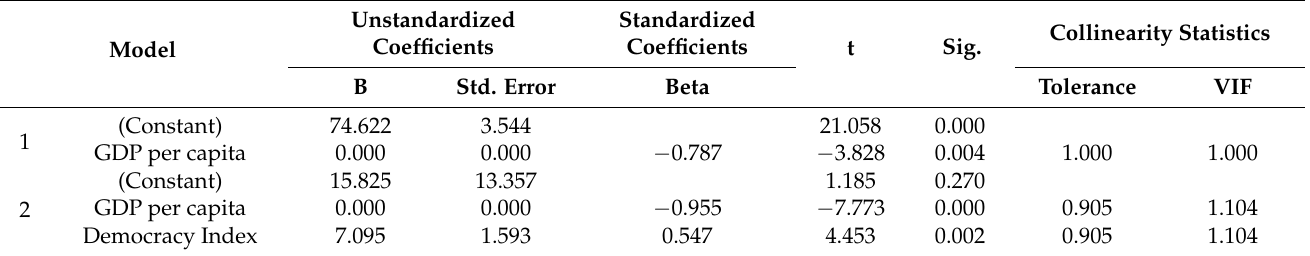
Table 3. Multiple linear equation of regression: Global Health Security Index in full democracies 1